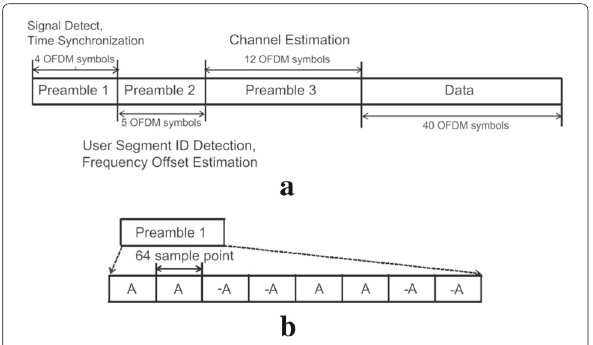
Fig. 3 Preamble design. a Packet format of the neighbor discovery packet. b Structure of the preamble of the first kind